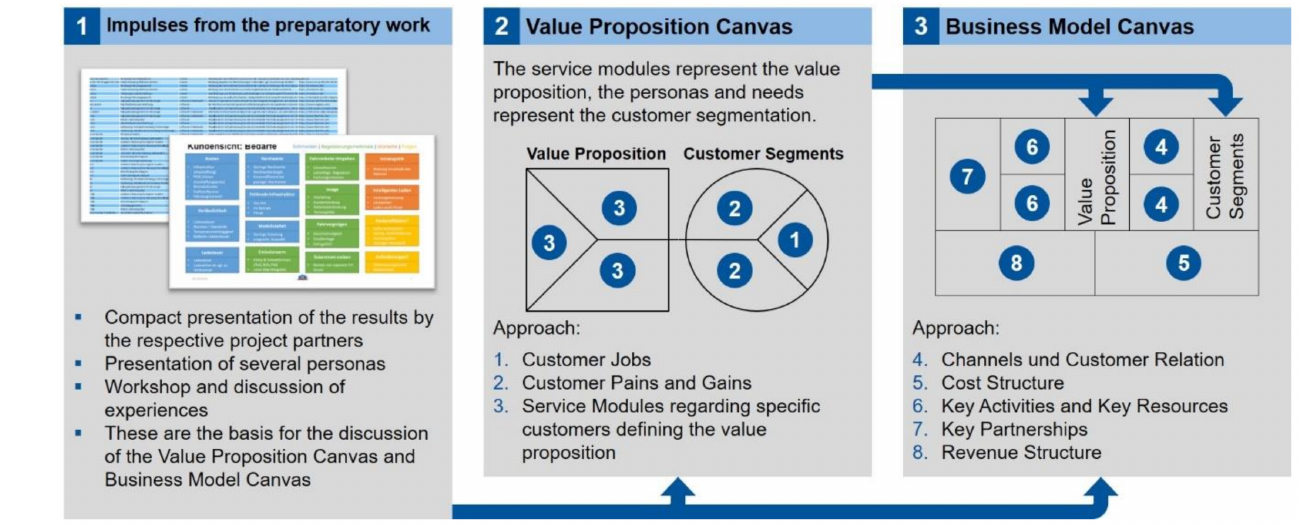
Figure 4. Approach to define and detail a business